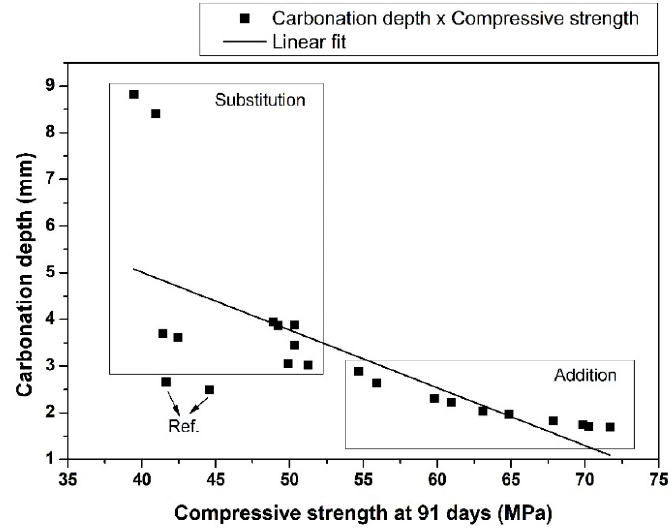
Figure 11. Carbonation depths of concrete.